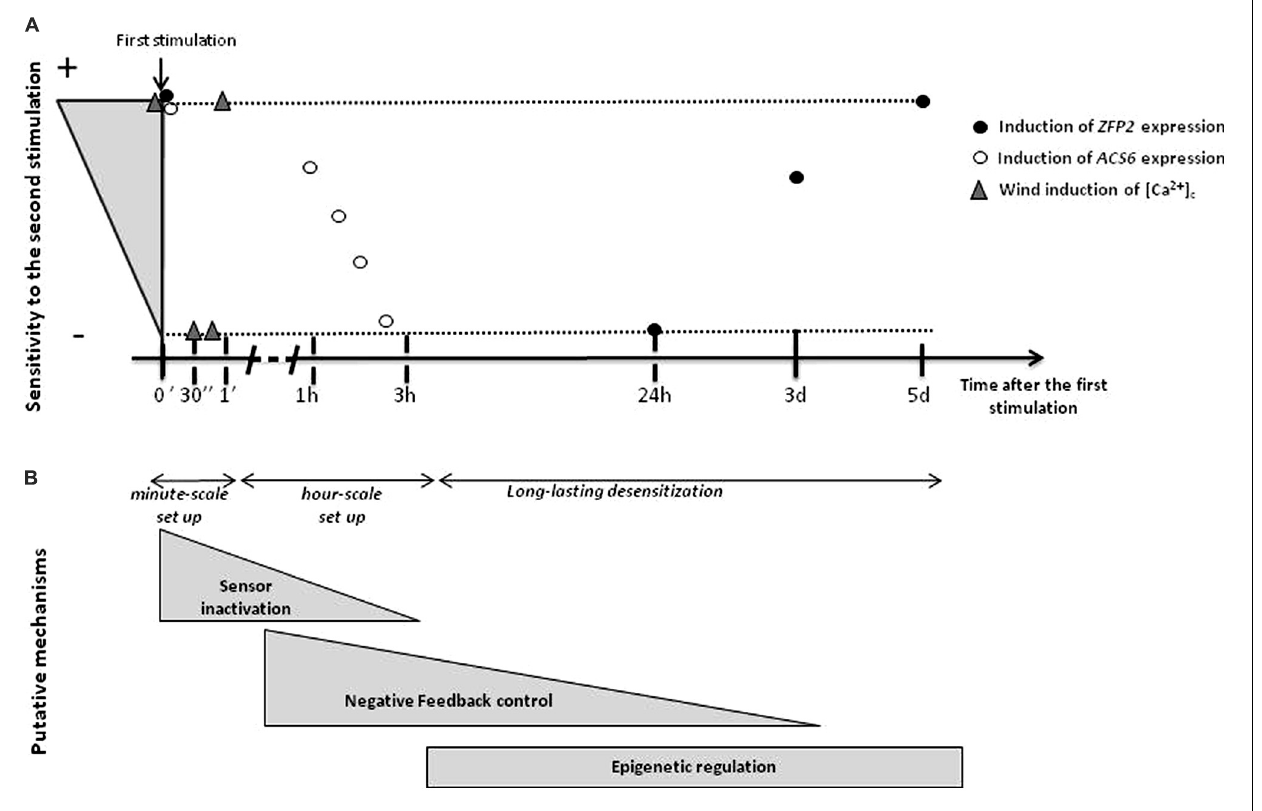
(Martin etal., 2010). (B) Hypothetical mechanisms for the short-term or long-lasting desensitization: (i) alterations of perception through sensor turnover, modification or in activation, (ii) negative feedback from long-term accumulation of signaling molecules or transcription factors and (iii) information storage through epigenetic